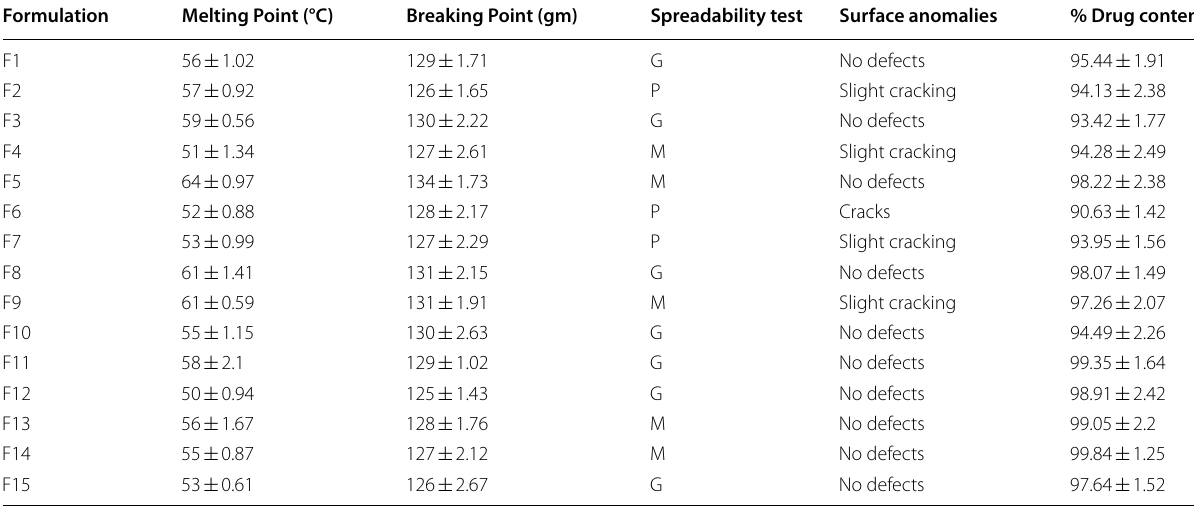
All the data are results of three analyses (n Letters ‘G’, ‘M’, and ‘P’ indicates the good, moderate, and poor spreadability of the formulations